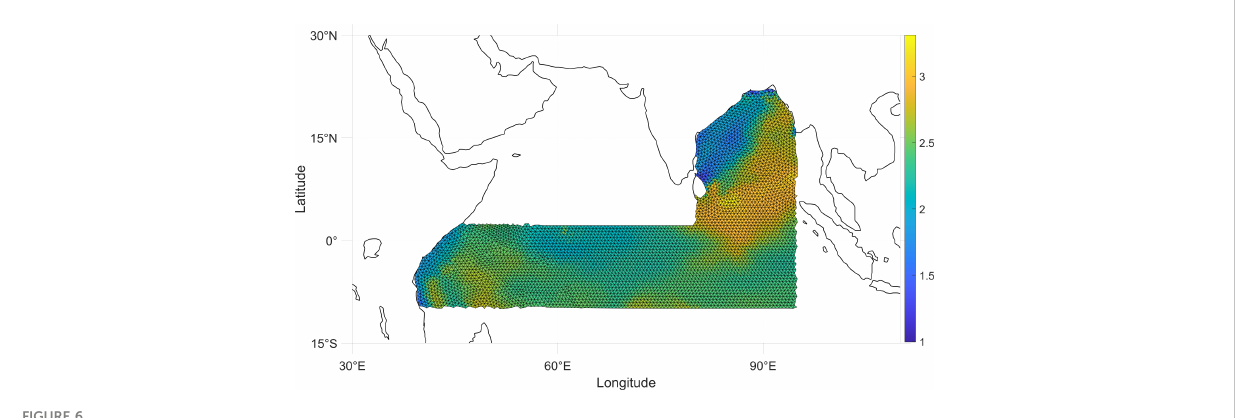
FIGURE 6 Unstructured grid in the study area.